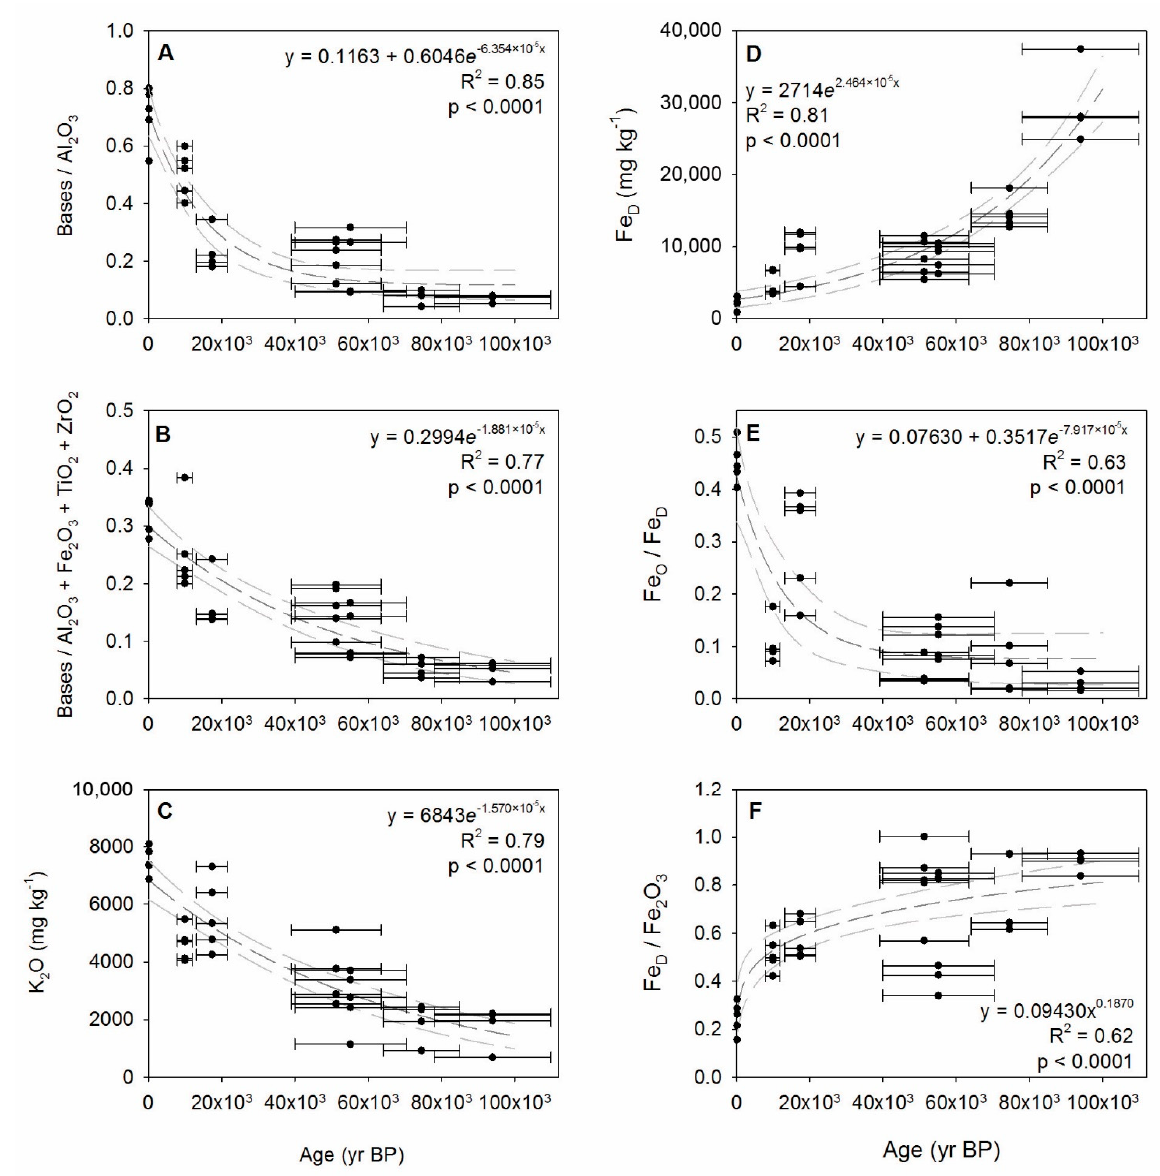
Figure 3. Chemical properties of the whole soil fraction (<2 mm) plotted as a function of mean age. ( A ) Bases to alumina ratio (Bases/Al 2 O 3 ); ( B ) Bases to resistant oxides ratio (Bases/R 2 O 3 ); ( C ) K 2 O; ( D ) Dithionite-extractable Fe (Fe D ); ( E ) Oxalate-extractable to dithionite-extractable Fe ratio (Fe O /Fe D ); ( F ) Dithionite-extractable to total Fe ratio (Fe D /Fe 2 O 3 ). Data were obtained from the most pedogenically well-expressed part of the subsoil and exclude measurements from modern channel alluvium. Results of nonlinear regressions with the function used for each parameter are shown. p - values apply to the significance level of the F-ratio for each regression, and gray dashed lines depict 95% confidence intervals. Error bars represent two standard deviations of the OSL age estimates.